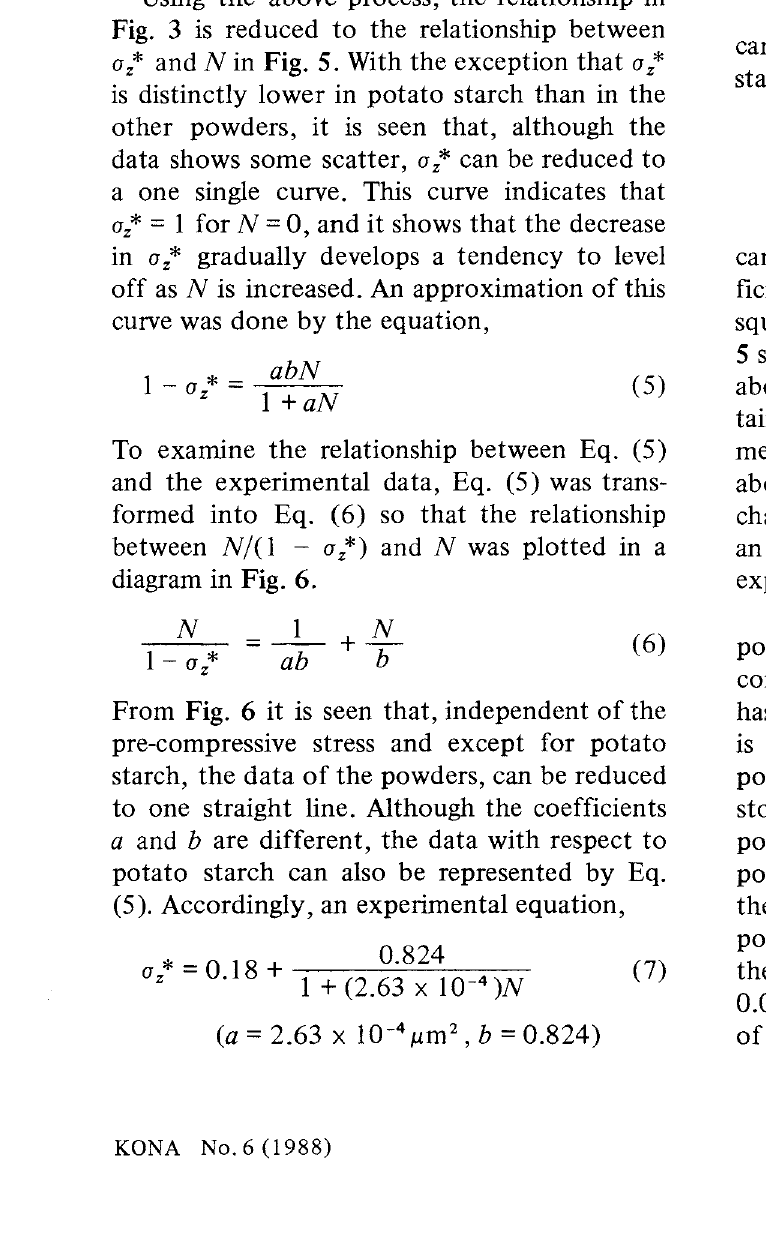
Fig. 6 Evaluation of experimental constants a and b of Eq.